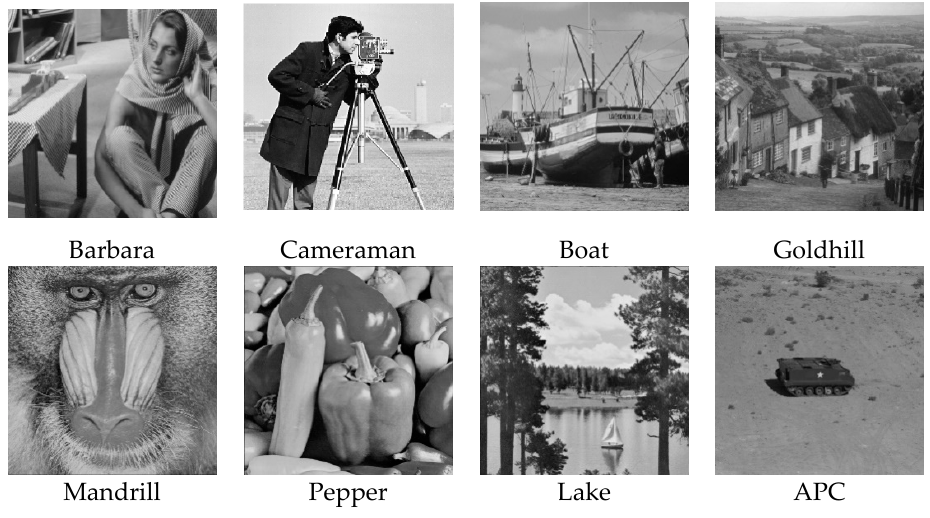
Figure 10. Standard test images [44] . Table 5. Simulation parameters.